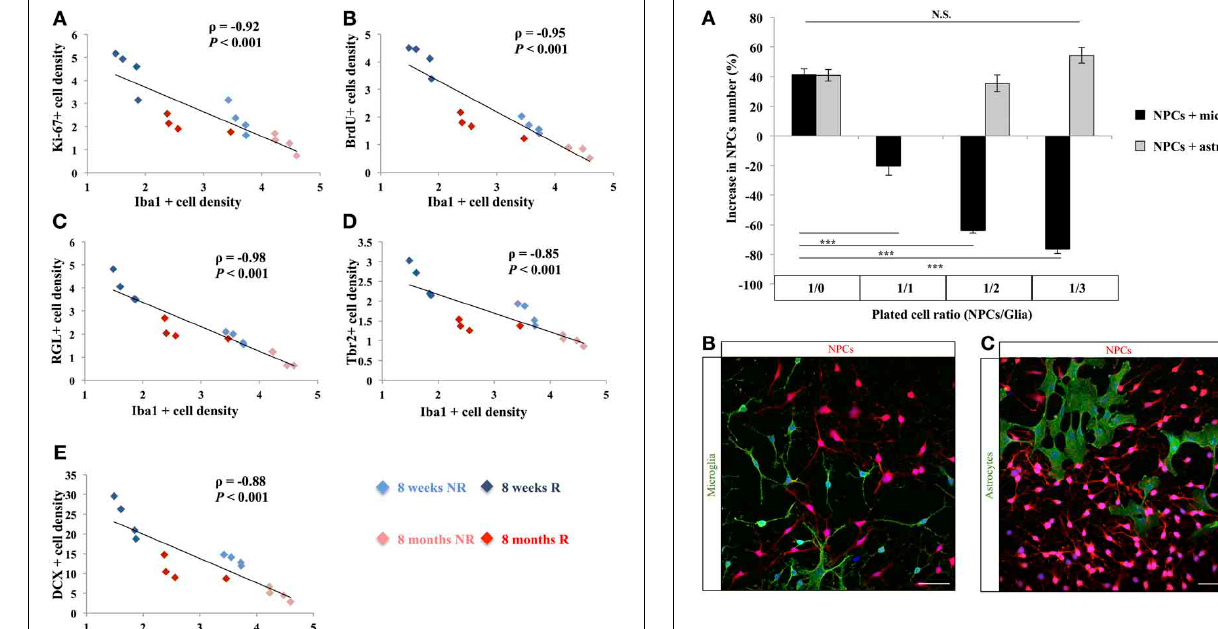
FIGURE 4 | Effect of microglia on progenitor cells in vitro . (A) Histogram of the change in NPCs number when cultured with microglia or astrocytes (% from the number of plated cells). N = 3 culture wells per group. (B) Confocal maximal projection micrographs of NPCs-microglia co-cultures. (C) Confocal maximal projection micrographs of NPCs-astrocytes co-cultures. N.S.: p > 0 . 05, ∗∗∗ p < 0 . 001. Each value represents the mean ±